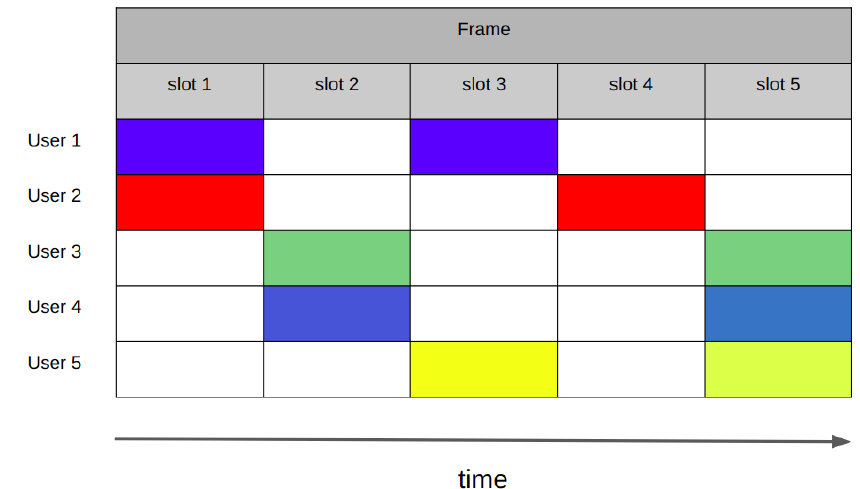
Figure 11. Example of the operation of contention resolution diversity slotted Aloha (CRDSA) over one frame. A collision-free packet from user two is received in the fourth slot. The packet includes the position of its “twin”, located in slot one. An interference cancellation method is then applied to the packet. In this example, packets from users one, two, and five can be successfully recovered, achieving an S = 0.6 for a load of C =